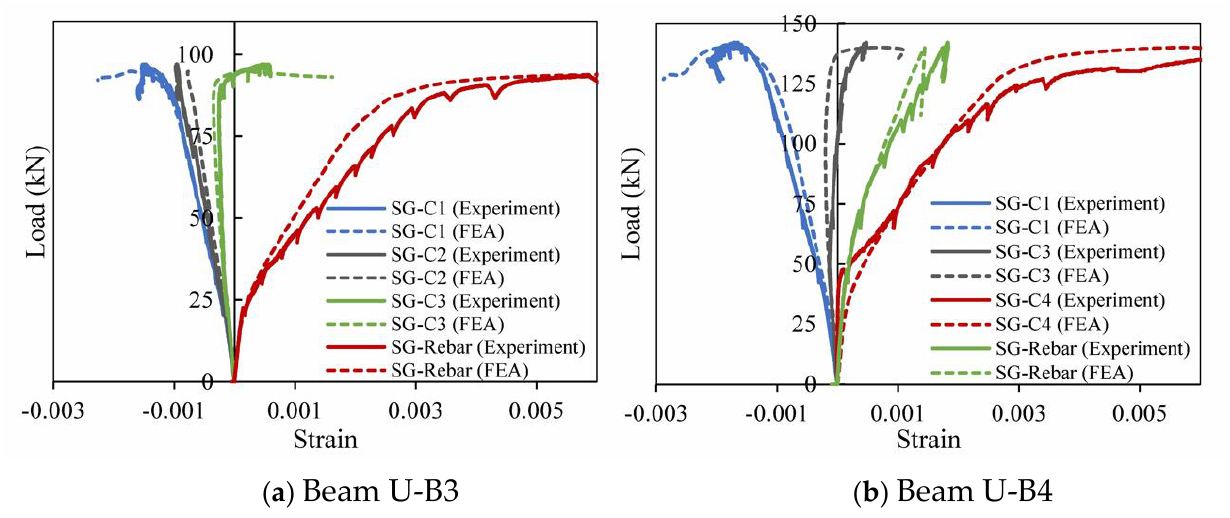
Figure 8. Comparison of load-strain response in bars and concrete at critical section of beams, as obtained from FEA and tests.